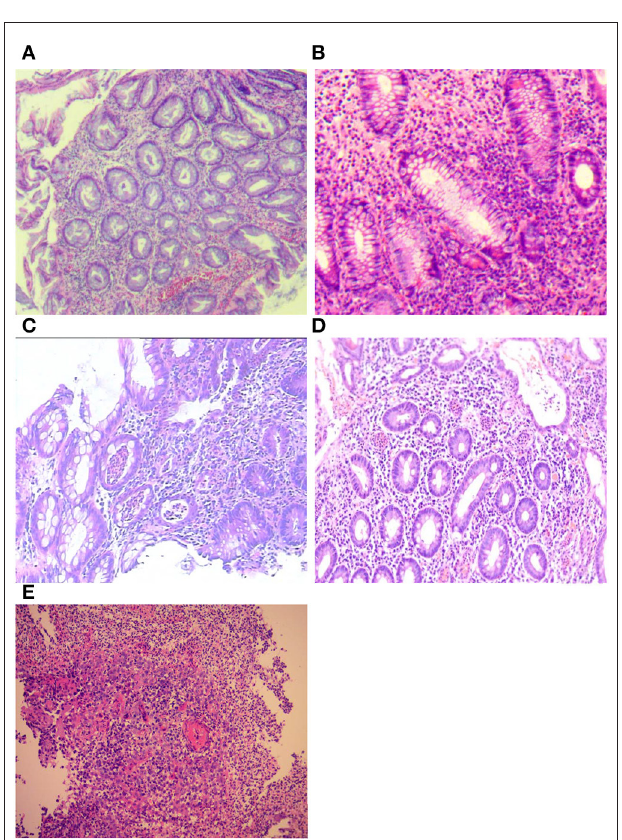
FIGURE 2 | Histological assessment of Nancy index (NI): (A) no significant histological disease (Grade 0); (B) chronic inflammatory infiltrate with no acute inflammatory infiltrate (Grade 1); (C) mildly active disease (Grade 2); (D) moderately active disease (Grade 3); and (E) severely active disease (Grade 4).